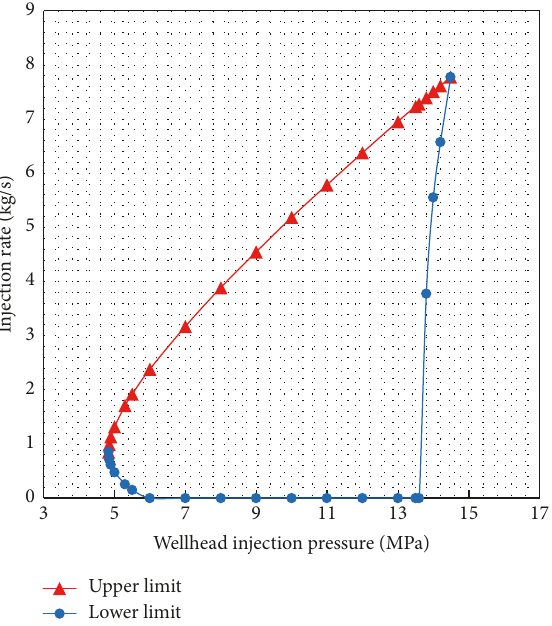
Figure 4: Relationship diagram between wellhead injection pres- sure and injection